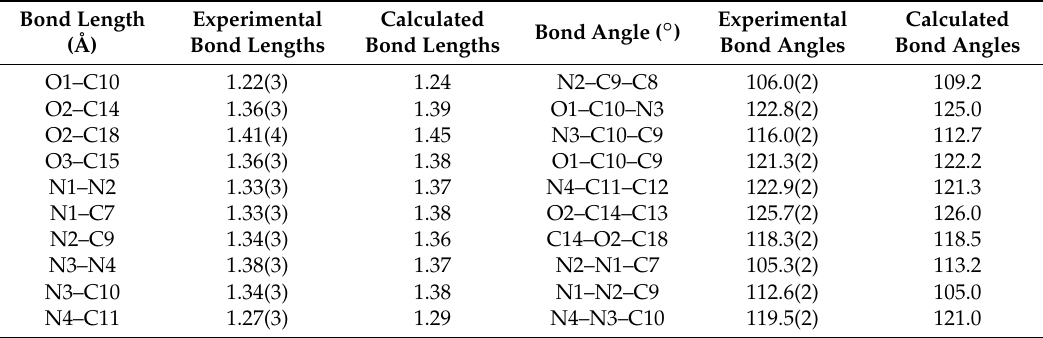
Table 1. Selected structural parameters by X-ray and theoretical calculations of compound L 1 .